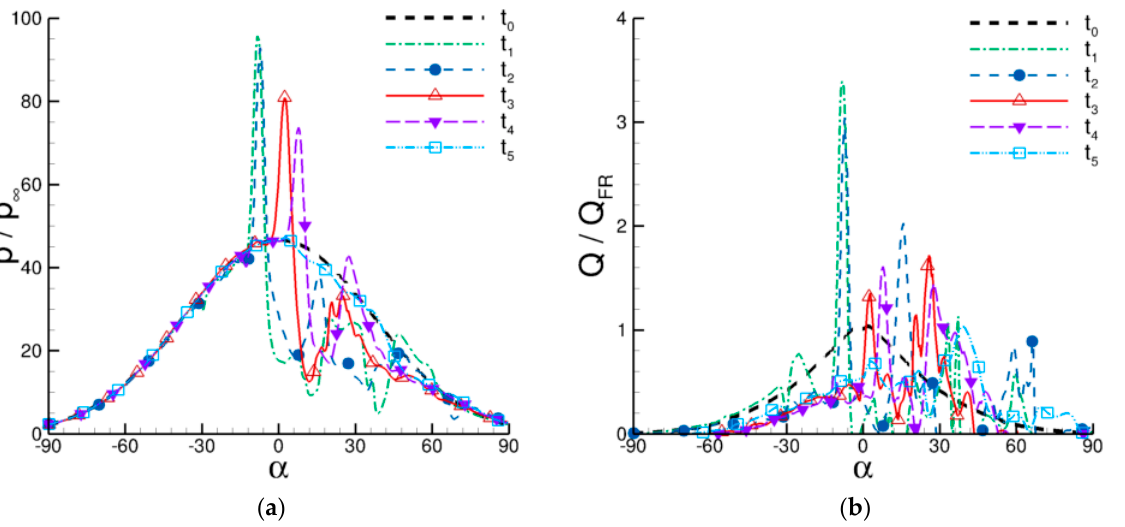
Figure 10. Pressure ( a ) and convective heat flux ( b ) oscillations on the sphere surface, induced by the gas-dynamic interaction of a pair of particles with a shock layer.